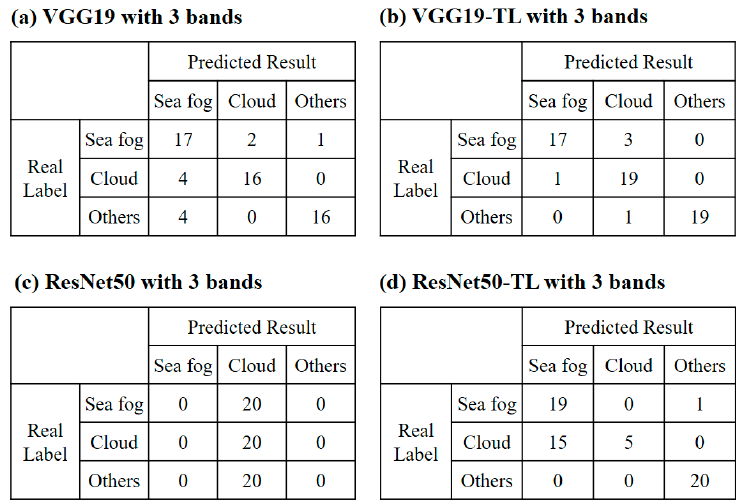
The confusion matrix explains how the two models correctly identified objects in Figure 6. remarkably increases the accuracy of ResNet50.